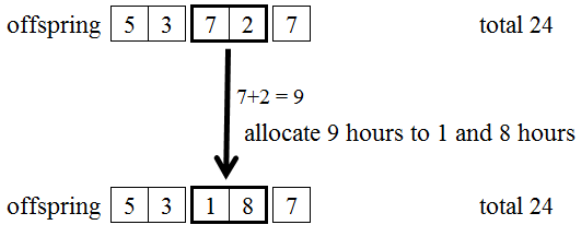
Figure 7. Mutation operation for elastic load encoding.